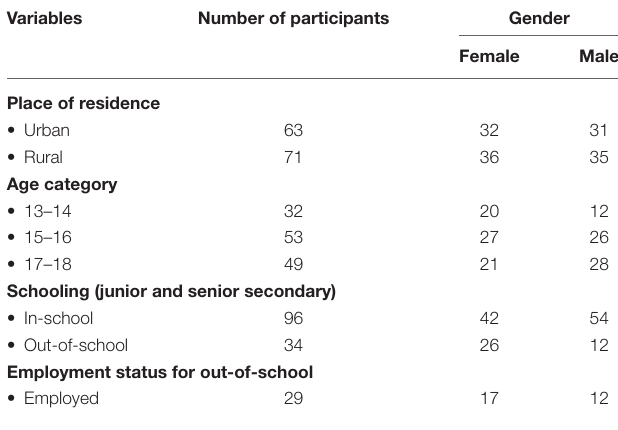
TABLE 1 | Socio-demographic distribution of focus group discussion (FGD)